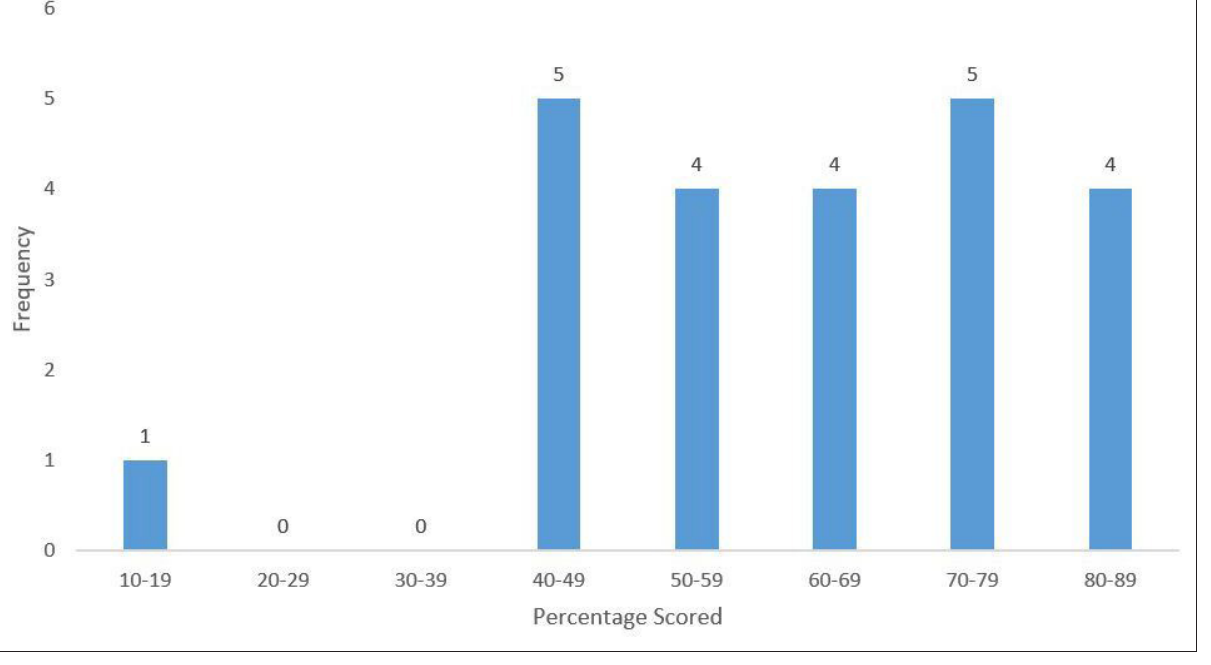
Figure 1 Distribution of total percentage scores for the consultations ( n =